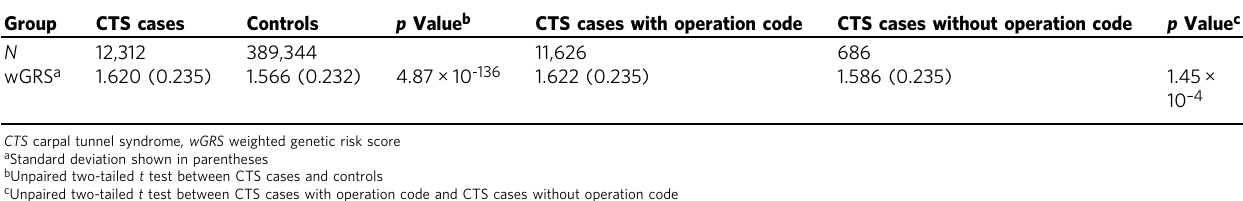
Table 4 Weighted genetic risk score in the UK Biobank cohort Group CTS cases Controls p Value b CTS cases with operation code CTS cases without operation code p Value c